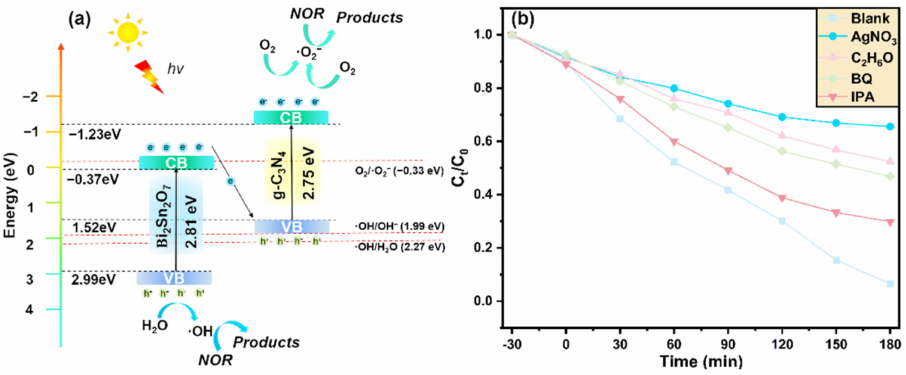
Figure 10. Possible mechanism of BSCN composite photocatalyst ( a ) and results of radicals quenching experiments ( b